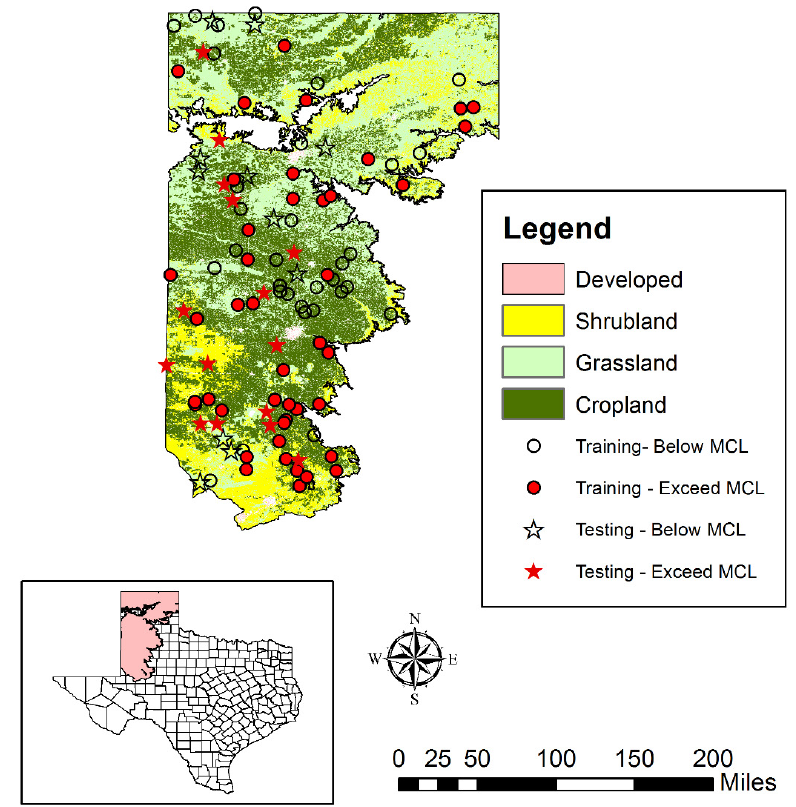
Figure 1. Study Area and Locations of Nitrate Monitoring Wells.